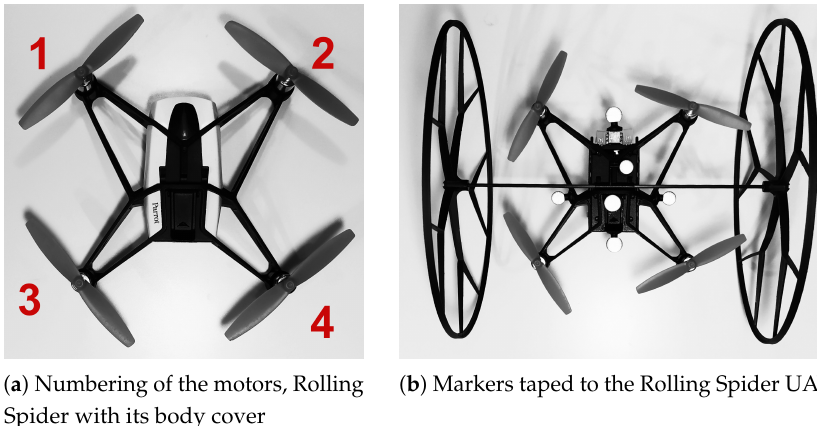
Figure 3. Experimental setup of the Rolling Spider.